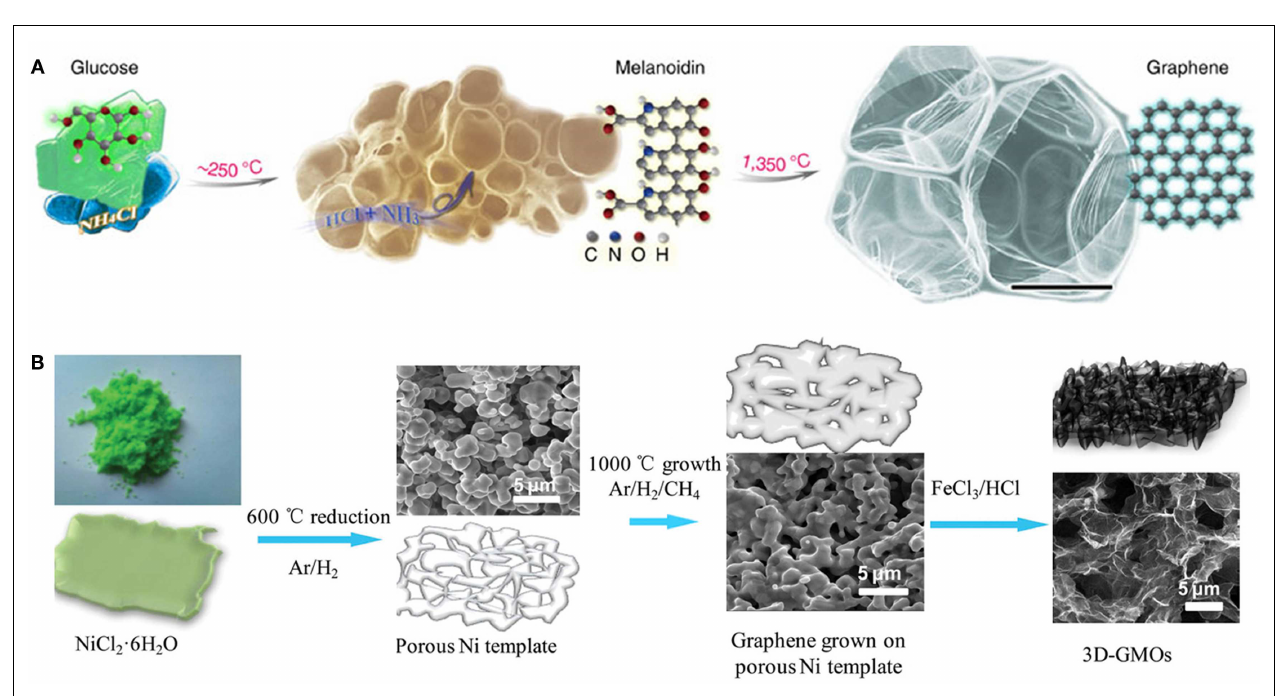
(B) Schematic illustrations displaying the preparation process of 3D graphene macroscopic objects. Adapted with permission from Li et al. (2013). Copyright 2013 Nature Publishing Group.